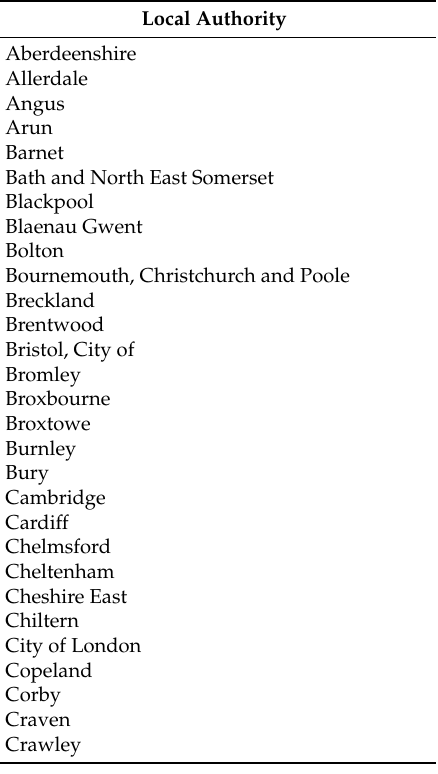
Table A8. List of local authorities that did not respond to the FOI